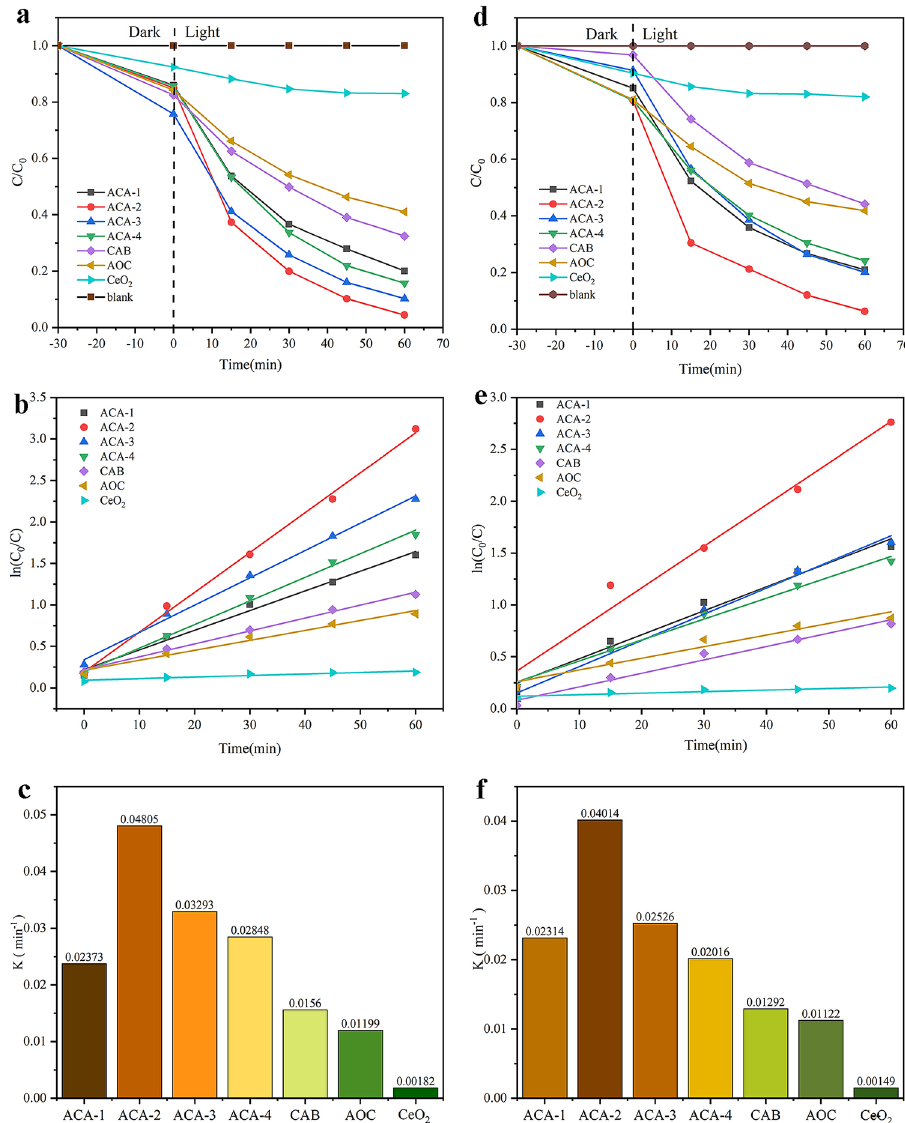
Figure 4. ( a–c ) Photocatalytic degradation RhB curves and Kinetic curves of RhB degradation; ( d–f ) Photocatalytic degradation TC curves and Kinetic curves of TC